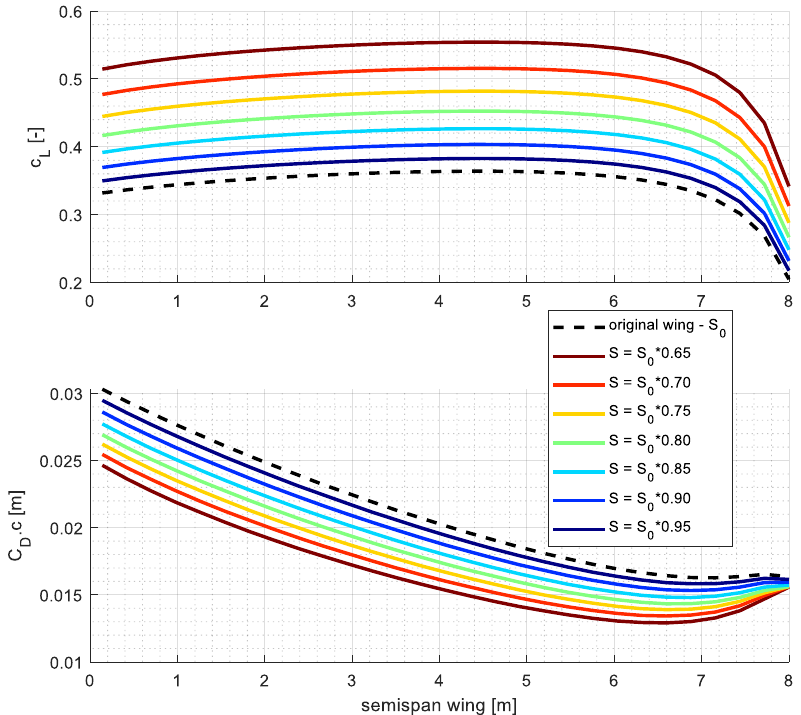
Figure 9. Lift and drag distribution over semispan wing for cruise regime.